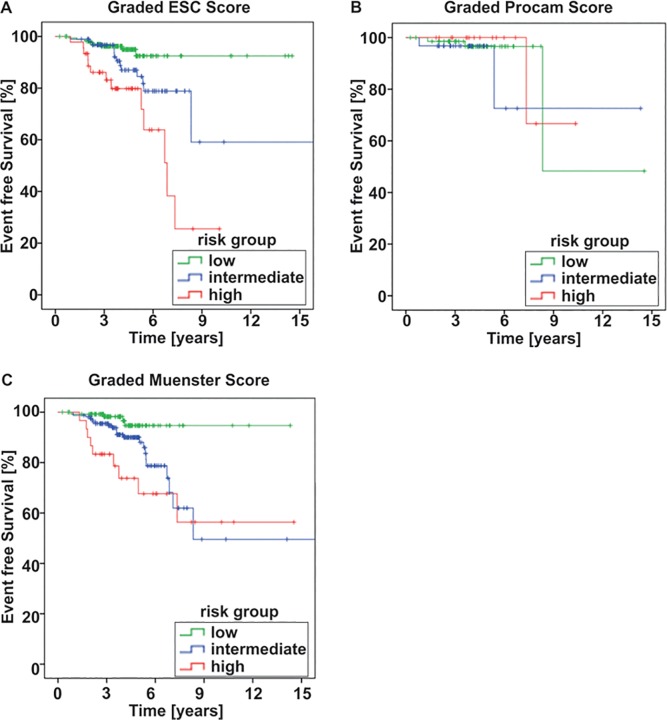
Event-free survival by graded ESC (A), PROCAM (B) and Muenster (C) score. Shown are the performances of low, intermediate and high risk groups for each score.